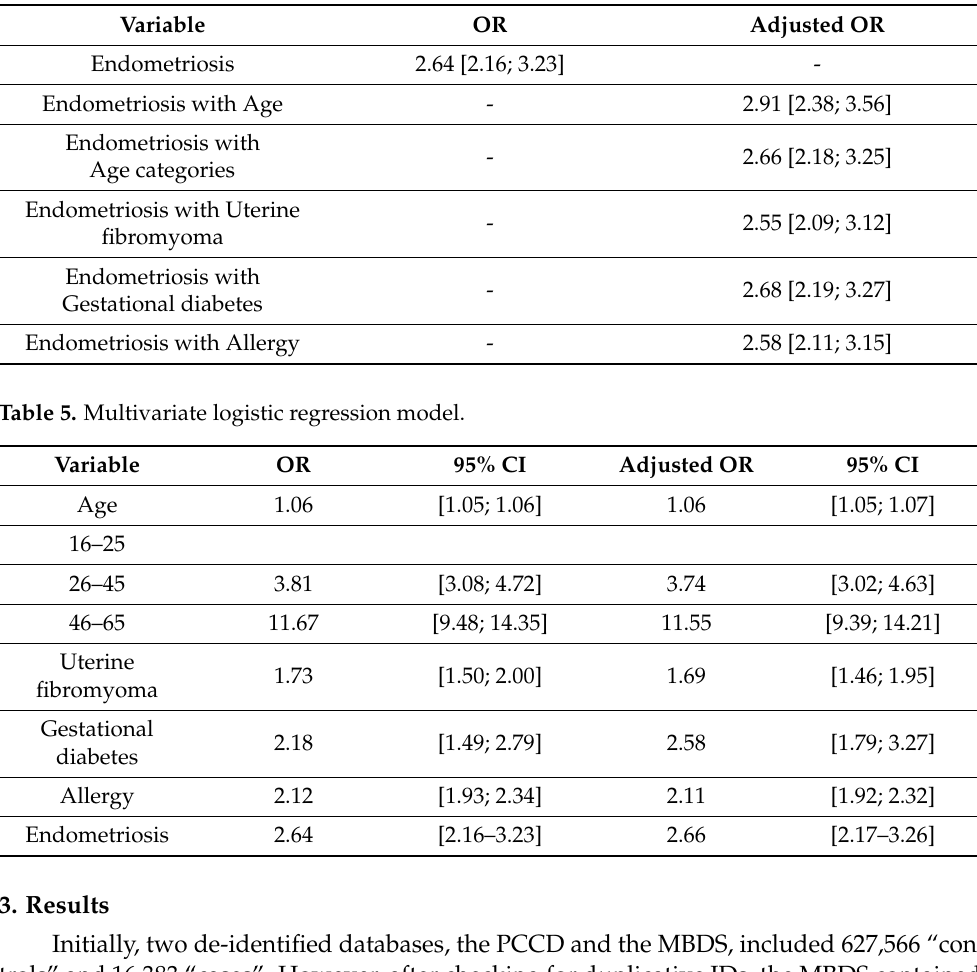
Table 4. Odds Ratios of endometriosis interaction with other predictive variables.